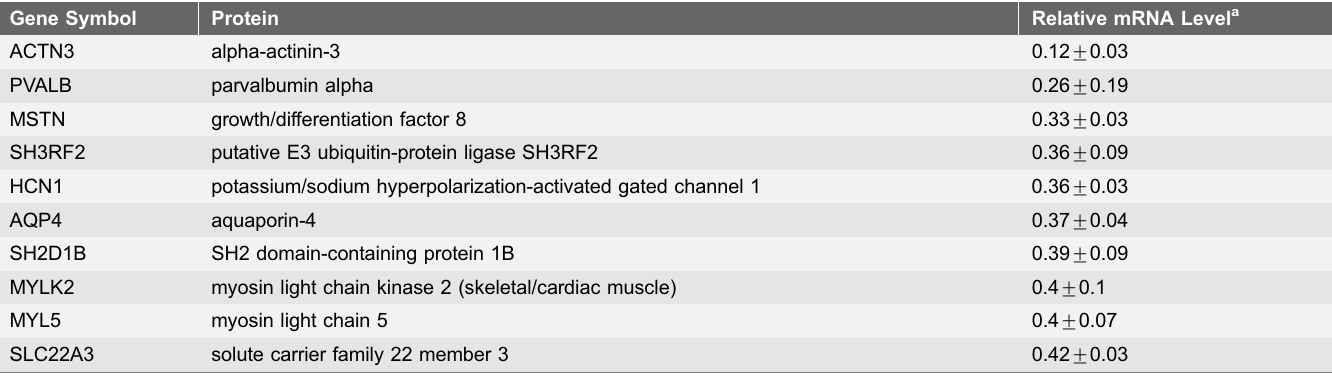
Table 4. Top 10 Repressed mRNA Gene Transcripts Following Chronic Training of Electrical Muscle Stimulation. Gene